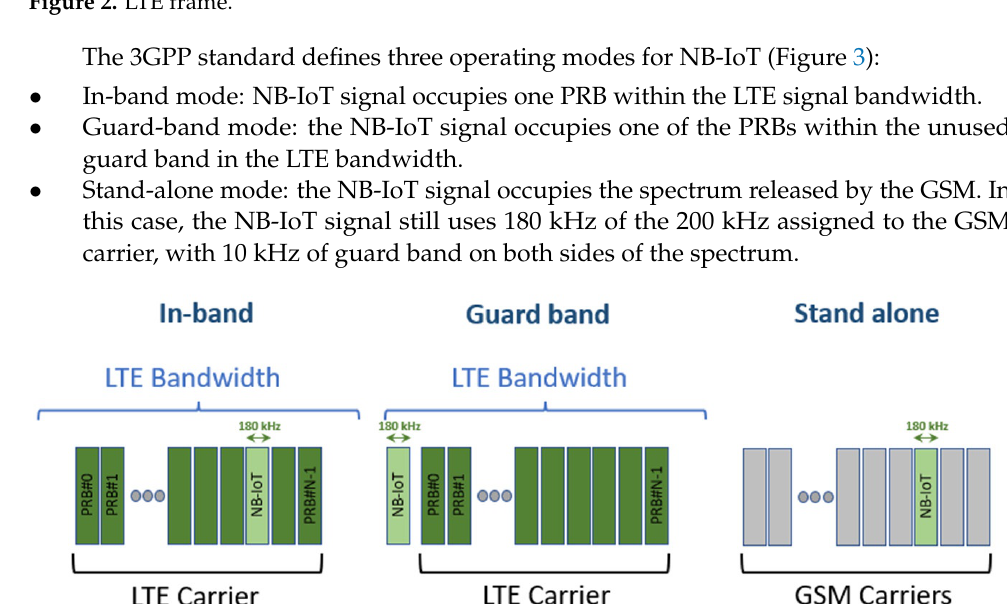
Figure 2. LTE frame.